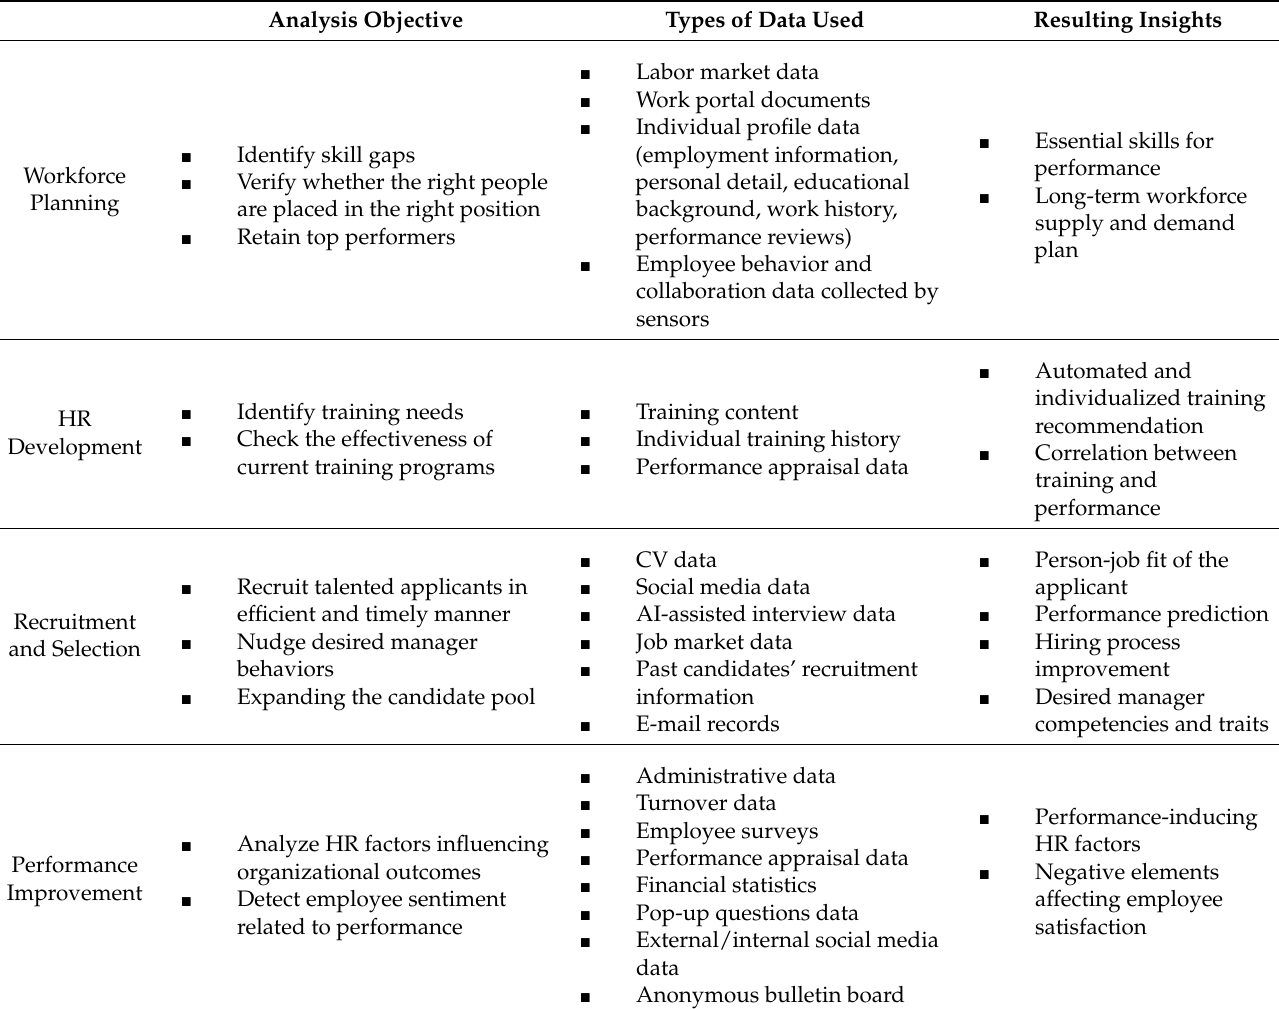
Table 1. Case Synthesis: Applications of HR